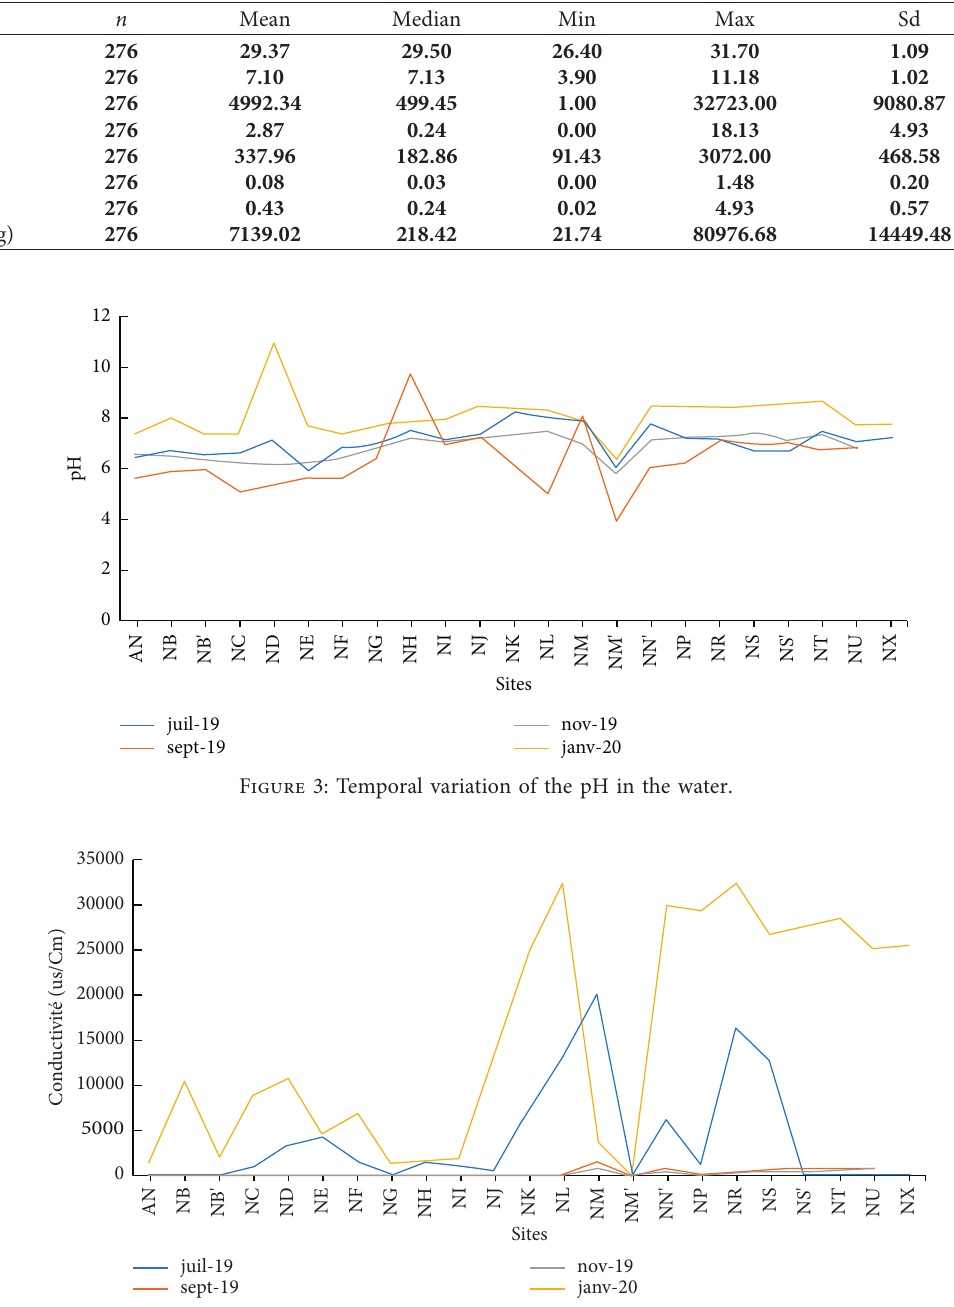
Figure 4: Temporal variation of the conductivity of Lake